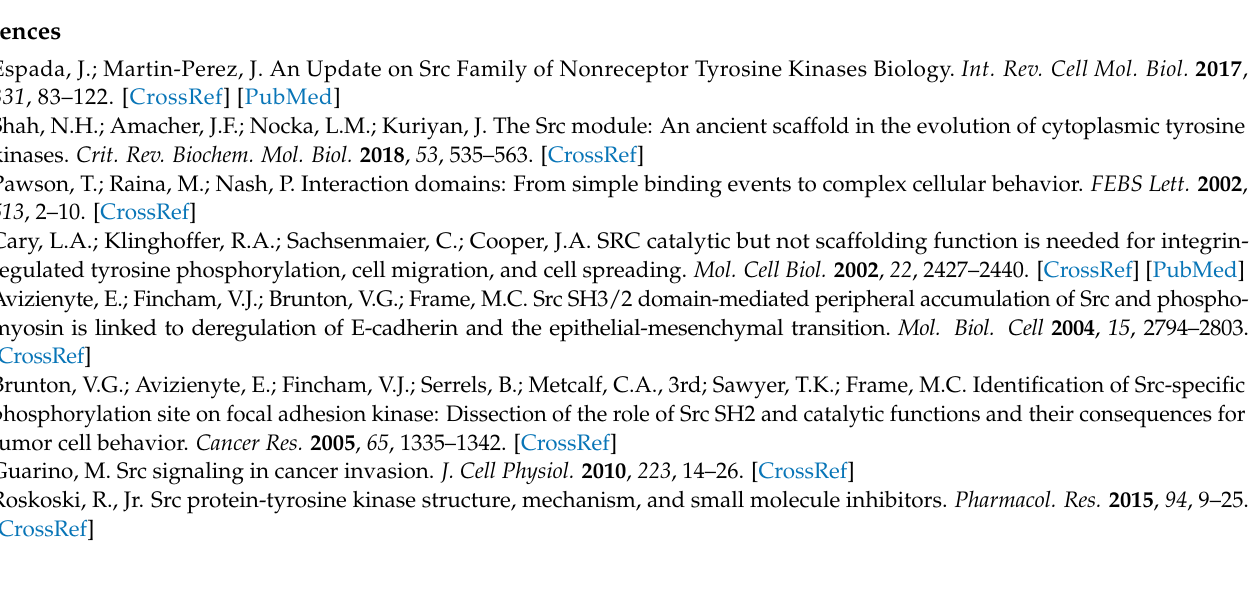
in SUM159 and MDA-MB-231 cells expressing c-Src variants. Referred to c-Src-wt as the control; Figure S12: Expression and activation of Caveolin 1, Paxillin, and Fak in SUM159 and MDA-MB-231 cells expressing c-Src variants. Referred to—Doxy as the control; Figure S13: Representative WB analyses of expression and activation of Caveolin 1, Paxillin, and Fak from the total cell extract from SUM159 and MDA-MB-231 cells expressing c-Src variants; Figure S14: Western Blot analyses of total c-Src, Fak, phosphorylated pY397-Fak, pY576-Fak, and Akt and phosphorylated pS473-Akt from SUM159 and MDA-MB-231 cells expressing c-Src variants; Figure S15: Confocal scanning microscopy analyses of pY14-Caveolin 1 and pY418-Src localization in SUM159 and MDA-MB-231 cells expressing c-Src variants; Figure S16: Kinetics curves of wound-healing assays of SUM159 and MDA-MB-231 cells treated with aptamers 14F and 17F; Figure S17: Representative images of wound-healing assays of SUM159 and MDA-MB-231 cells treated with aptamers 14F and 17F; Figure S18: Analyses by WB of expression of proliferation markers Myc, Cyclin D1, p27 Kip1 , and of migration Caveolin 1, Paxillin, and Fak in SUM159 and MDA-MB-231 cells treated with aptamers; Table S1: Detailed information for antibodies used in this work. Authentication of SUM159PT and MDA-MB-231 cell lines by short-tandem-repeat analyses. Uncropped gels of Figures 1–4, S3, S7, S8, S9, S12,